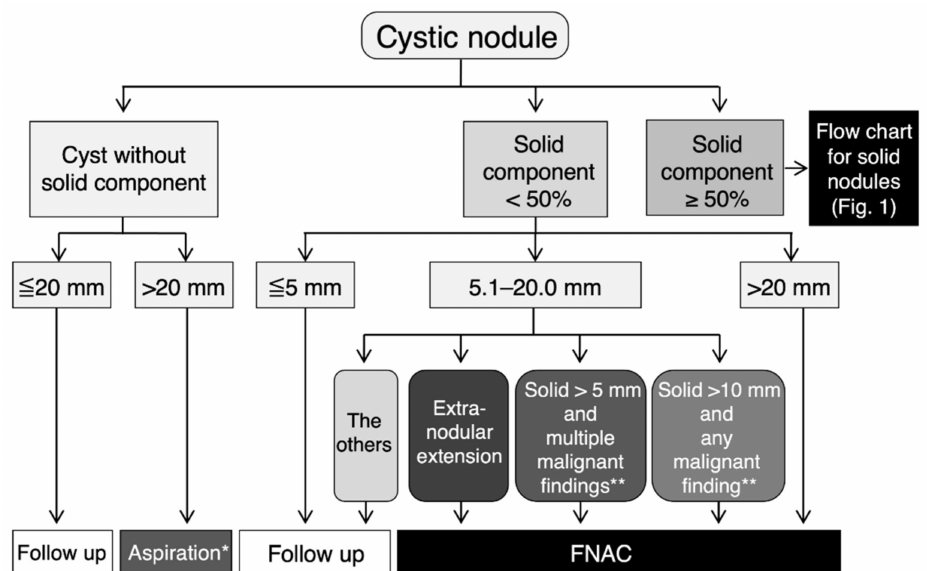
Figure 3. Flow chart for the management of cystic thyroid nodules in Japan. This flow chart for the management of cystic thyroid nodules was published by the Japan Association of Breast and Thyroid Sonology. This figure was created based on Figure 4 of Chapter V in Thyroid Ultrasound–A Guidebook for Diagnosis and Management, 3rd edition [25], with the permission of Nankodo Corp. * Aspiration of cyst fluid is considered for cysts that are 20.1 mm or greater in diameter to relieve symptoms. ** Irregular surface of solid component, multiple fine high-echo spots, and increased blood